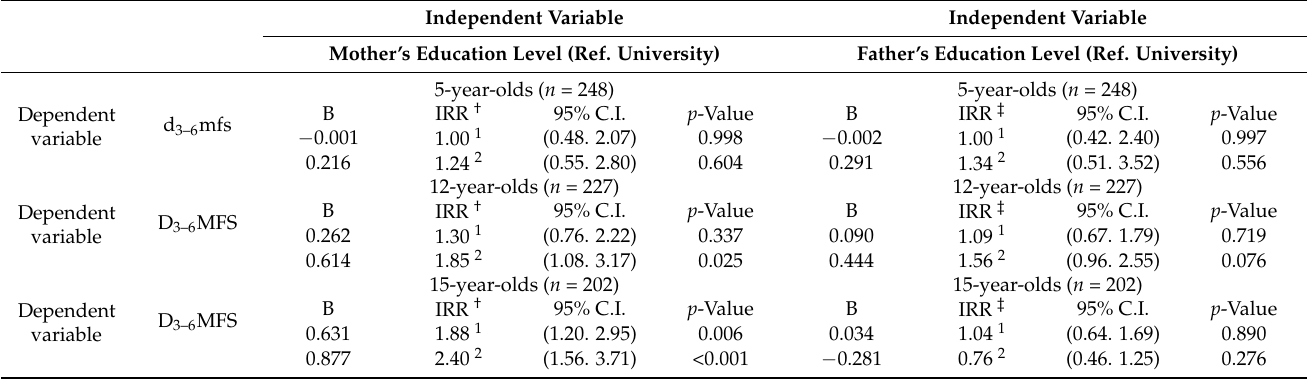
Table 4. Effect of parental education level on the d 3–6 mfs/D 3–6 MFS of the 5-, 12- and 15-year-old children of immigrant origin in Greece (negative binomial regression